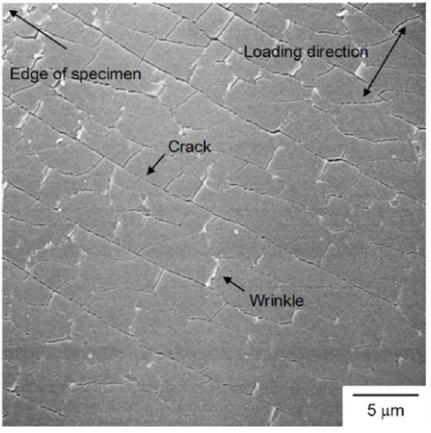
Figure 10. SEM micrograph of ITO/PET sheet after tensile bending with a 5 mm curvature radius for 1000 h, as viewed from the ITO side.